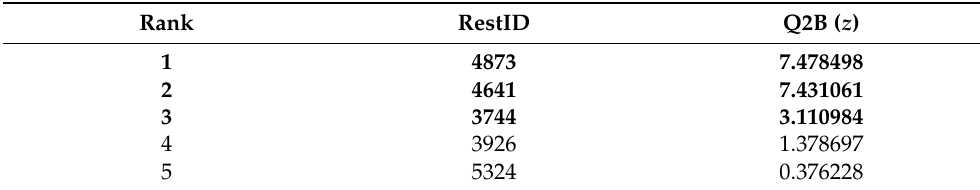
Table 6. Q2B results for input Query